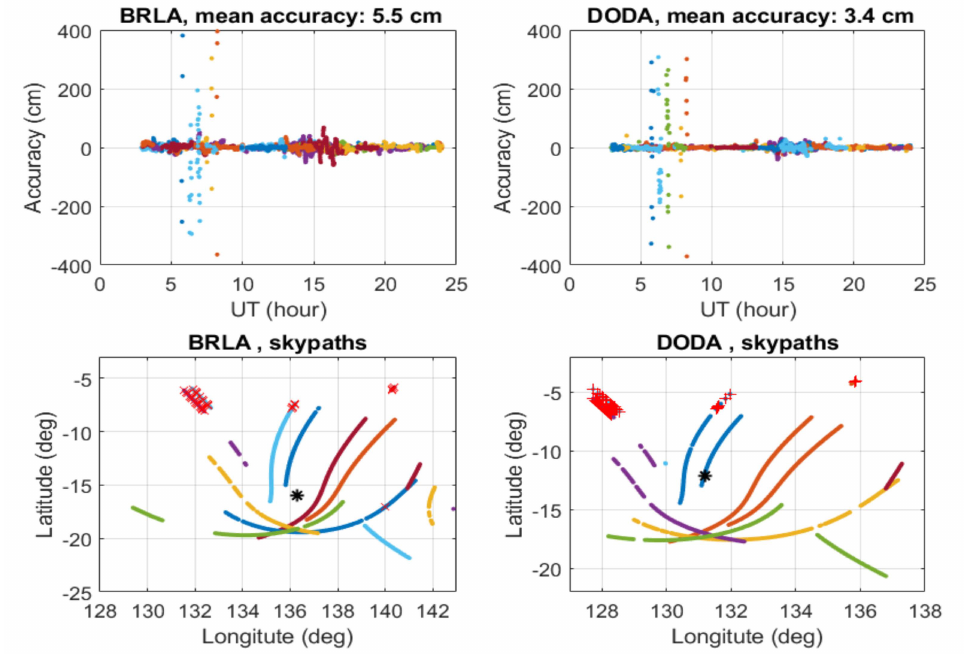
Figure 14. ( Top ) The differences between the interpolated and measured ionospheric corrections as a function of time of stations BRLA and DODA on 6 May 2021. ( Bottom ) The sky paths of all satellites received during 5 to 10 UT observed by BRLA and DODA stations. The line colours represent each GPS satellite. The red crosses show an accuracy higher than 50 cm. The black asterisk at each figure shows the location of testing station BRLA or